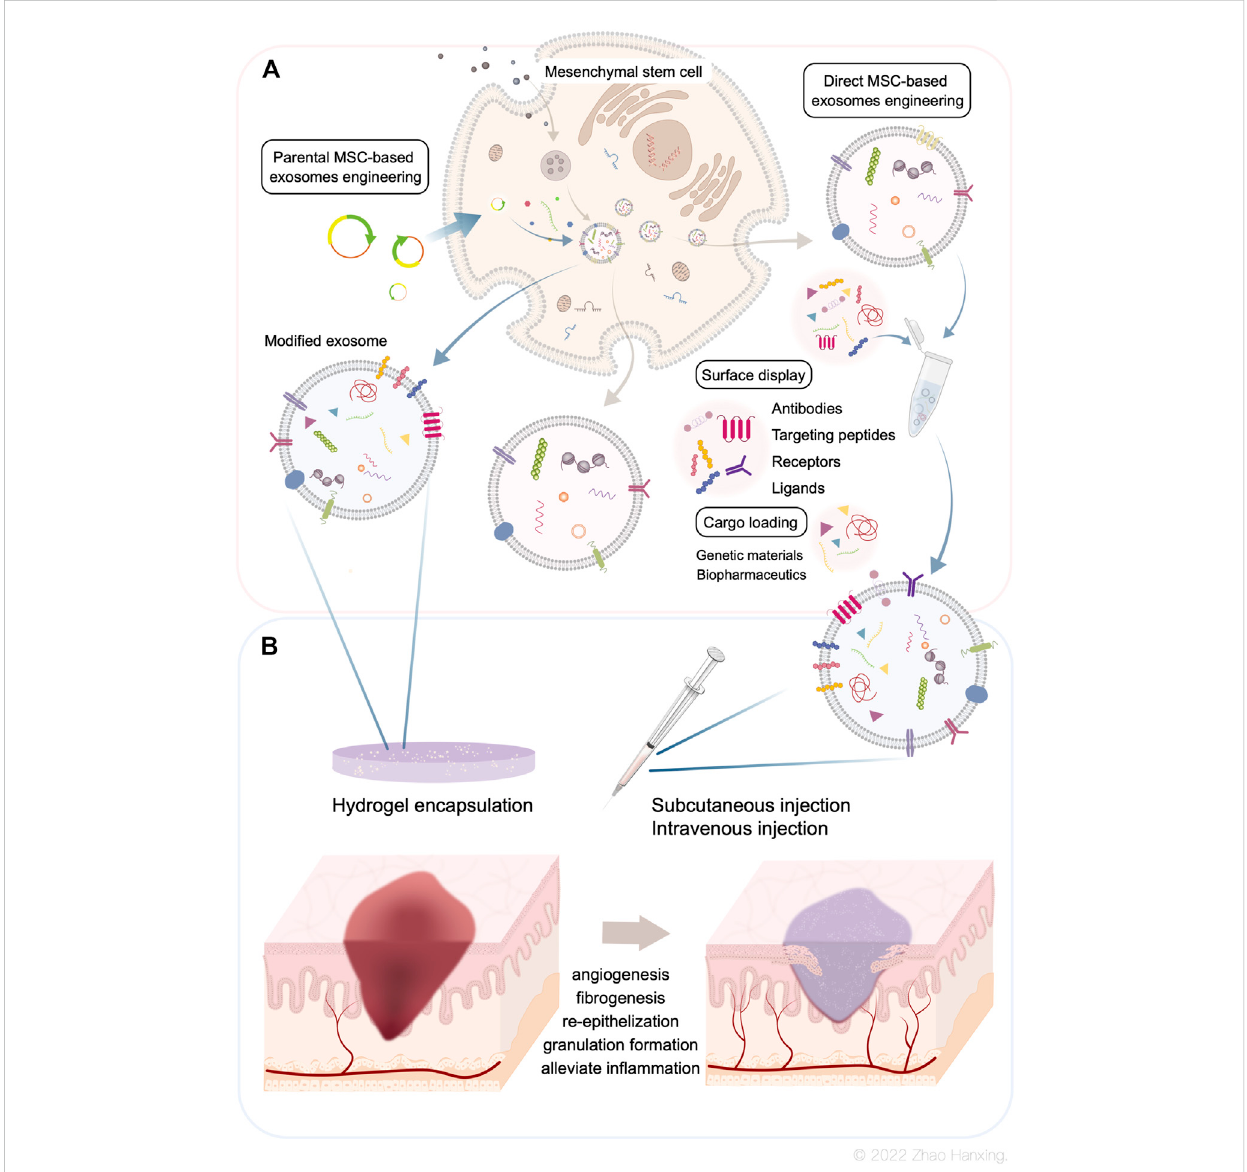
FIGURE 1 (A) Biogenesis of Mesenchymal stem cell-derived exosomes. The bioengineering modi fi cations include genetic modi fi cation of MSCs and direct modi fi cation of exosomes. (B) Current administration procedures of modi fi ed exosomes are co-administration with hydrogels and administered by intravenous, subcutaneous, or intraperitoneal injections. Modi fi ed MSC-exosomes could accelerate skin wound repair by promoting angiogenesis, fi brogenesis, re-epithelization, and granulation tissue formation, as well as alleviate in fl ammation.